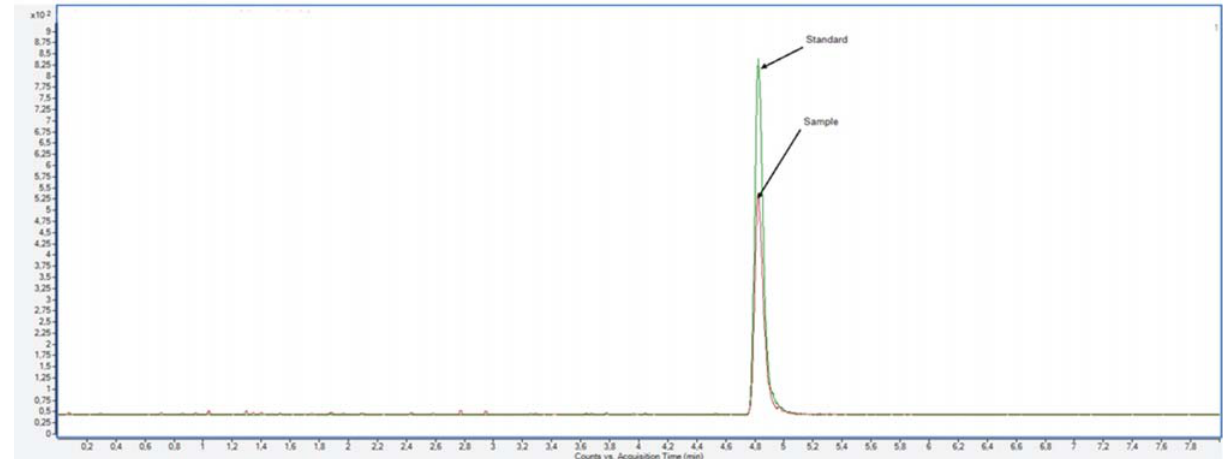
Figure 2. Extracted MRM quantifying ion (273.1) chromatograms of AFM1 standard (100 ng/mL) and naturally contaminated milk sample no.